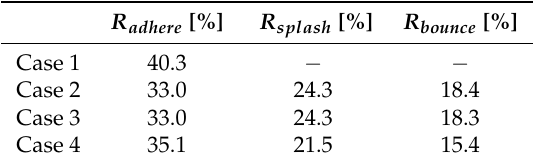
Table 5. Effect of the SLD model and temperature on each